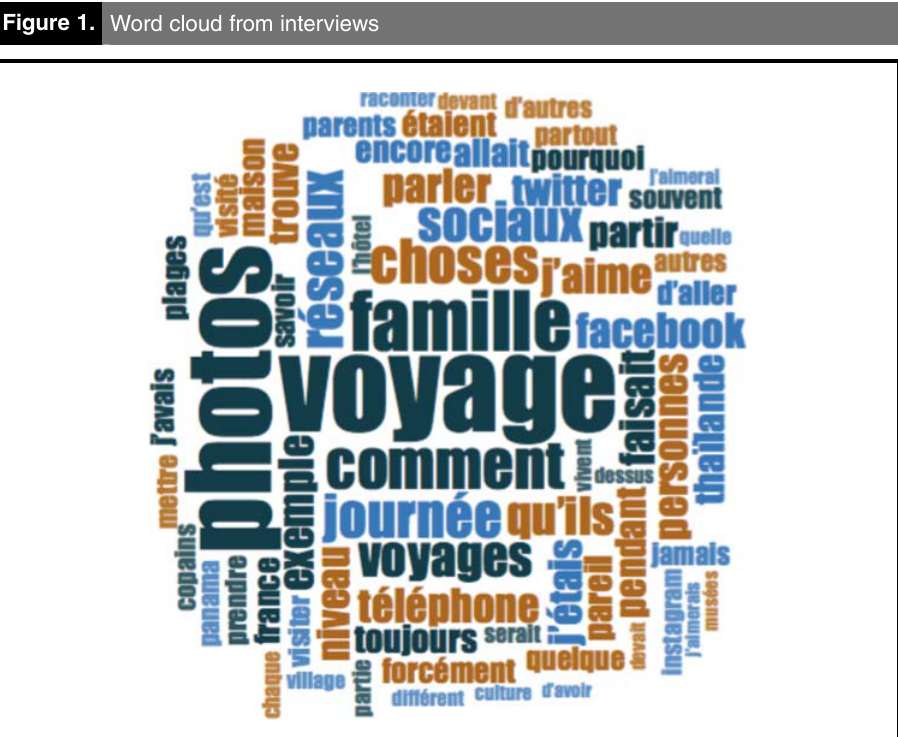
Figure 1. Word cloud from